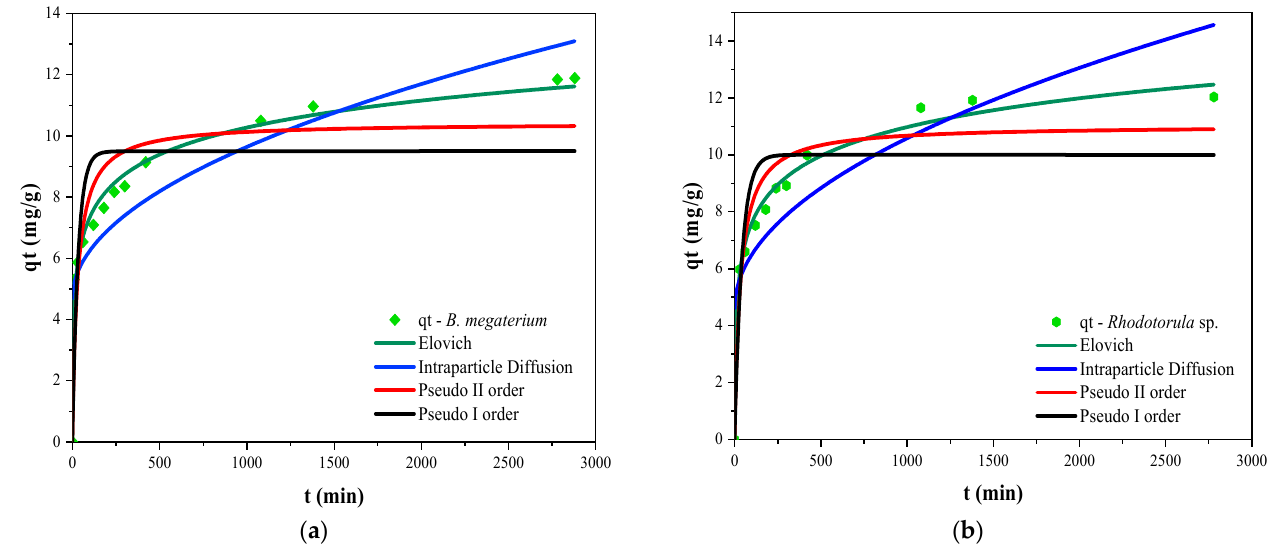
Figure 7. Plots of non ‐ linear forms of pseudo I order model, pseudo II order model, Elovich model and intraparticle diffusion model for Cr 6+ biosorption by ( a ) Bacillus megaterium and ( b ) Rhodotorula sp. inactive biomass. Table 3. Values of the kinetic models’ parameters for Cr 6+ biosorption by Bacillus megaterium and Rhodotorula sp. inactive biomass.